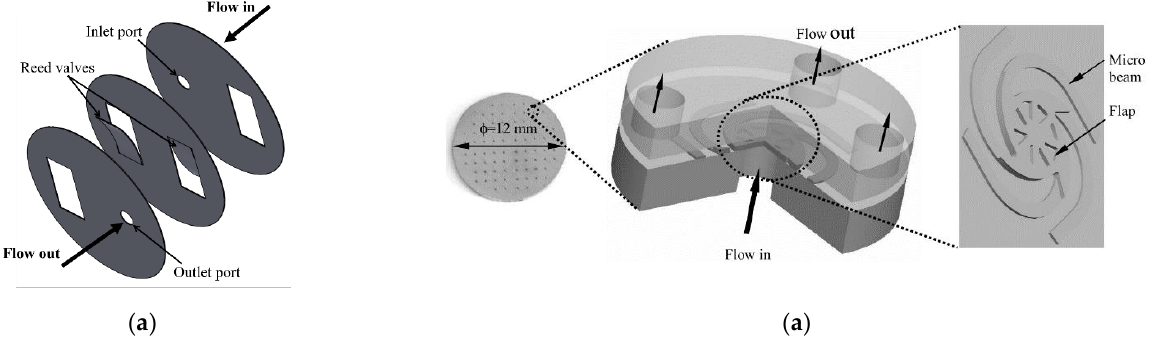
Figure 15. ( a ) Structure of cantilever reed valves. ( b ) Structure of micro arm valves (from [177]).